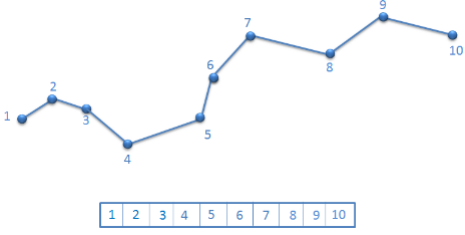
Figure 4. An instance solution and its representation as a vector